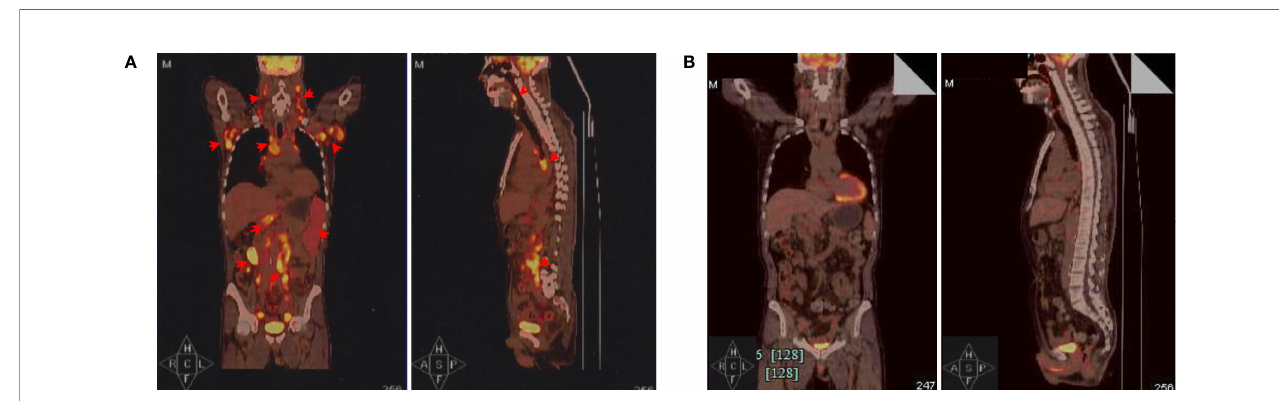
FIGURE 1 | Positron emission tomography and computed tomography (PET-CT) evaluations. (A) PET-CT before CAR-T cell infusion. The coronal image (left) and sagittal image are shown (right). Red arrows indicate lymphoma lesions. (B) PET-CT examination showed signi fi cantly diminished lymphoma lesions and proved complete metabolic remission (CMR) 3 months after CAR-T cell